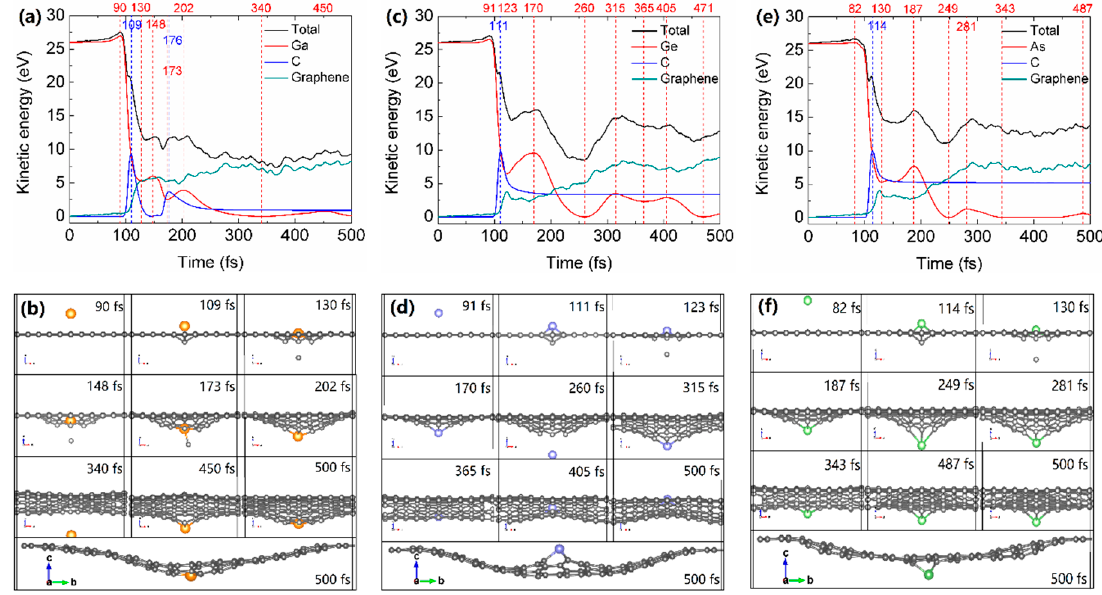
Figure 4. The atomic-scale energetics and snapshots of 26 eV ( a ) Ga, ( c ) Ge and ( e ) As atoms implanting into graphene. The total kinetic energy of 161 atoms (black), as well as kinetic energies of the incident Ga/Ge/As atom (shown in red color), sputtered C atom (blue), and all remaining 159 C atoms in the graphene layer (green) as a function of time. ( b , d , f ) are snapshots of atomic configurations that correspond to time steps marked in ( a , c , e ) by vertical dashed lines. Ga, Ge and As atoms are shown in orange, purple and green, respectively, C atoms are shown in gray.